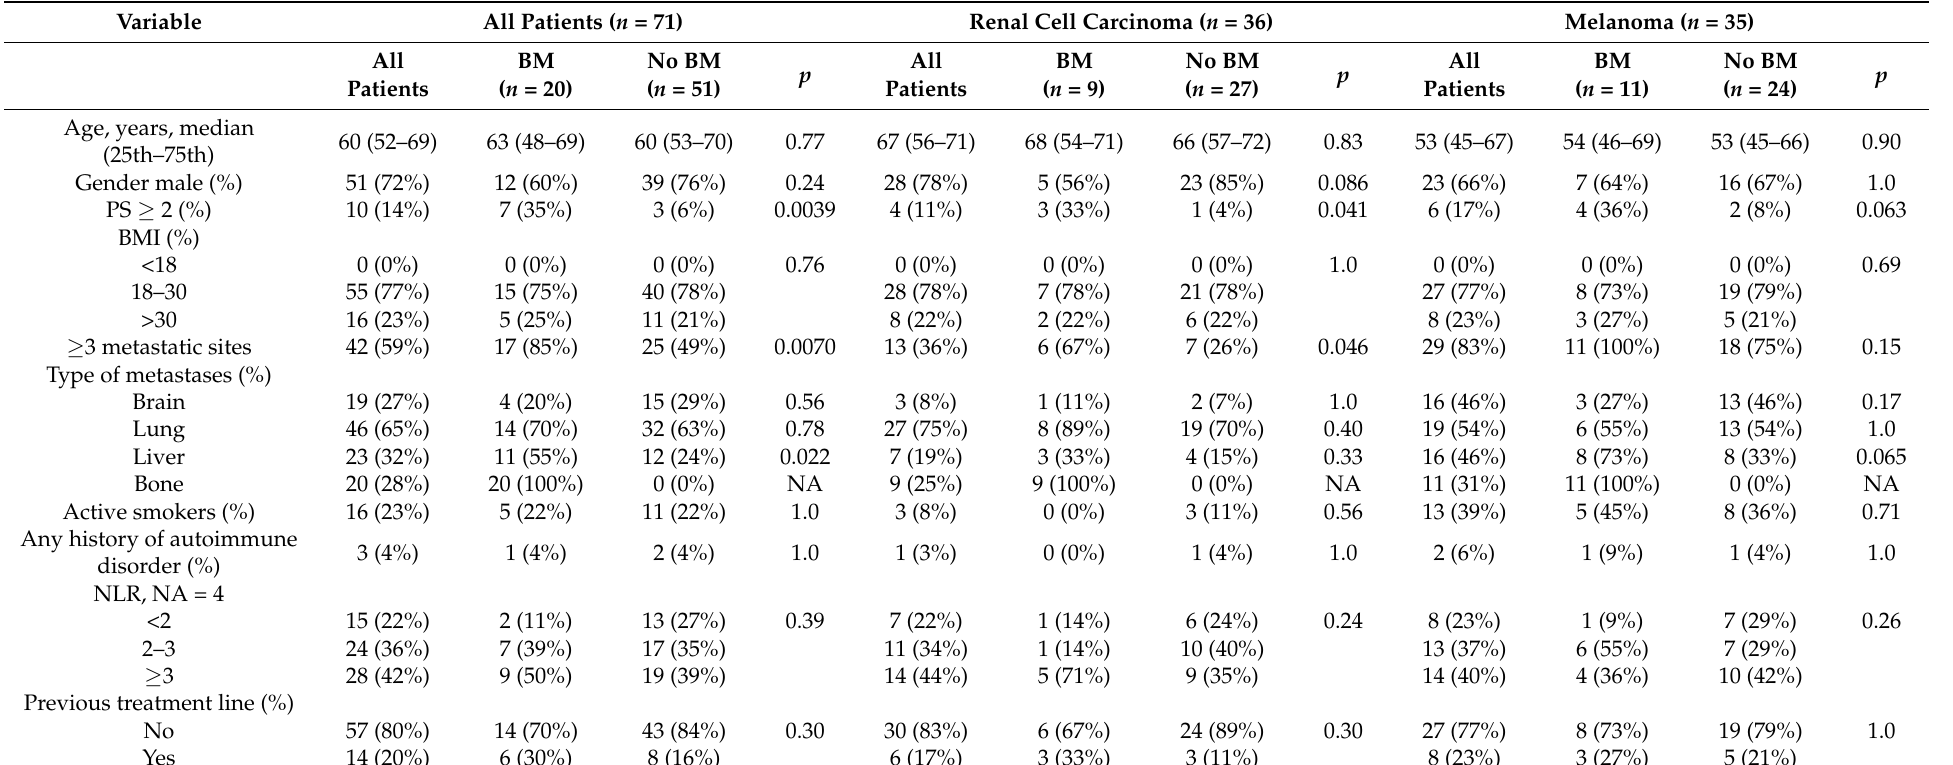
Table 1. Baseline patients characteristics according to tumor type at initiation of